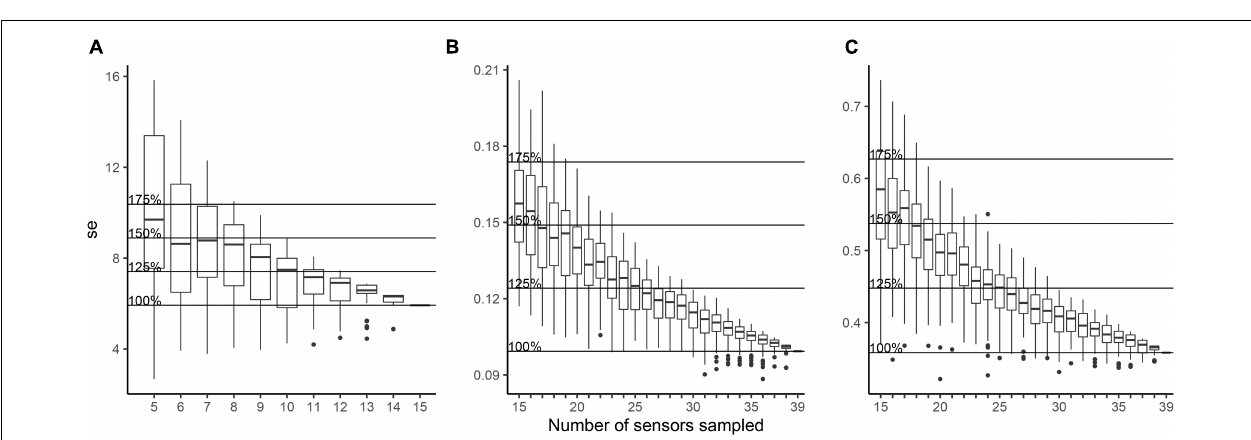
FIGURE 6 | Monte Carlo analysis of the standard error for radiation (A) , temperature (B) , and RH (C) , according to the number of sampled sensors. The horizontal lines show the total standard error of the data (e.g., 100%) and the consequential increase of the error (e.g., 1.25, 1.5, and 1.75 * the standard error) as the number of sensors is